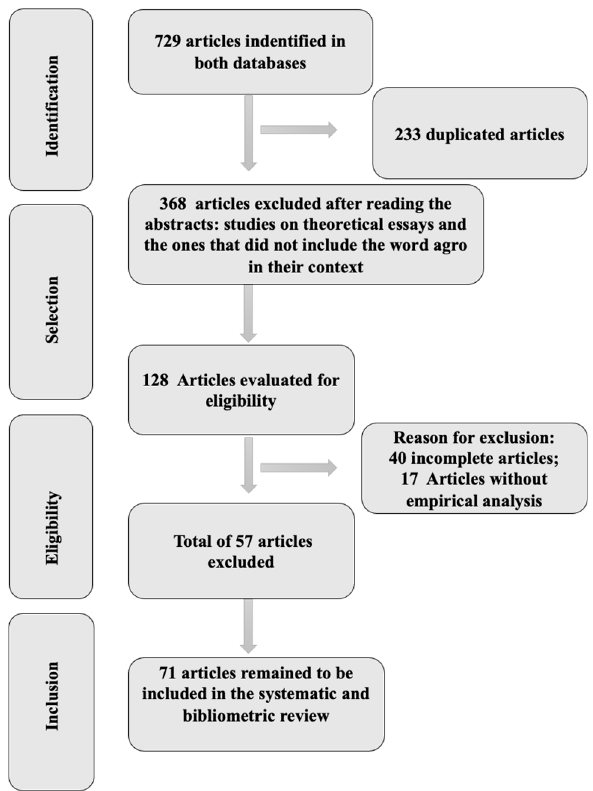
Figure 2. PRISMA flowchart and selection of articles for bibliometric and systematic review.